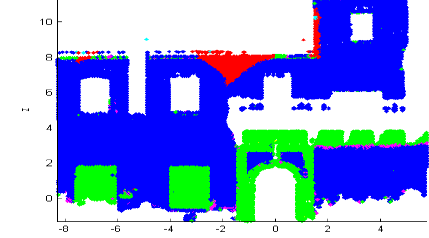
Figure 7. Second step segmentation result with td = 0.2 m, tr = 30, Vr = 900 and tr 2 = 60. 5 segments are found (blue, green, red, magenta, cyan).